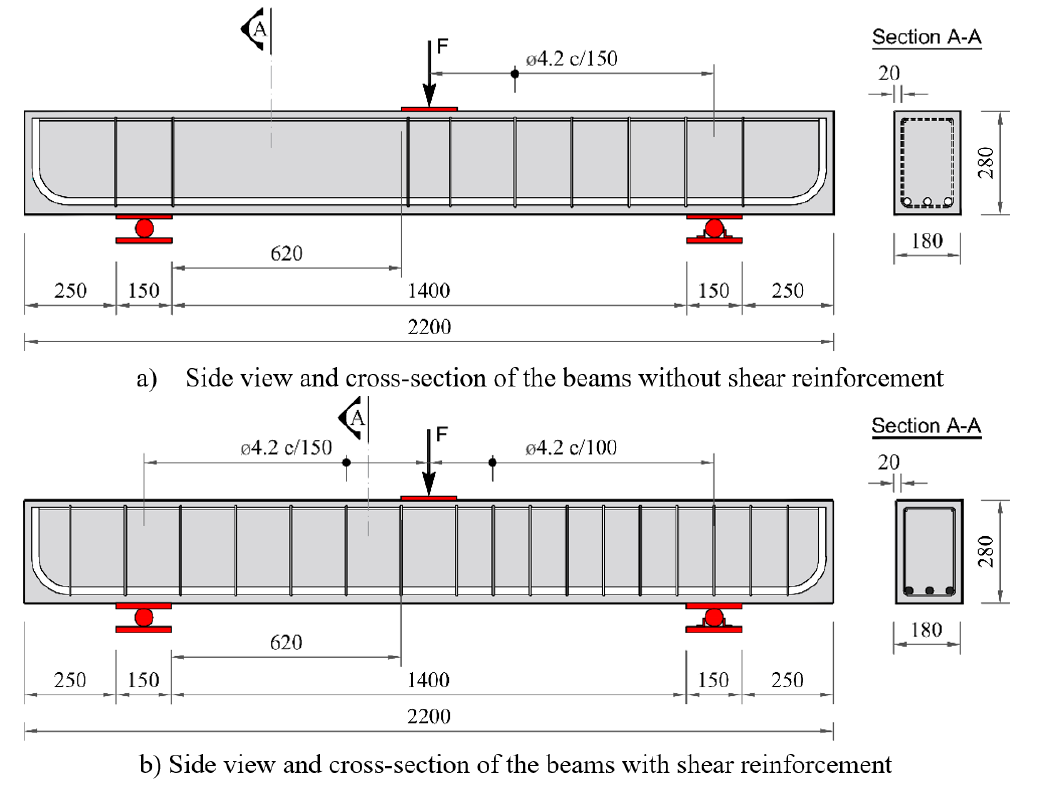
Figure 2. Flexural and shear reinforcement of the tested